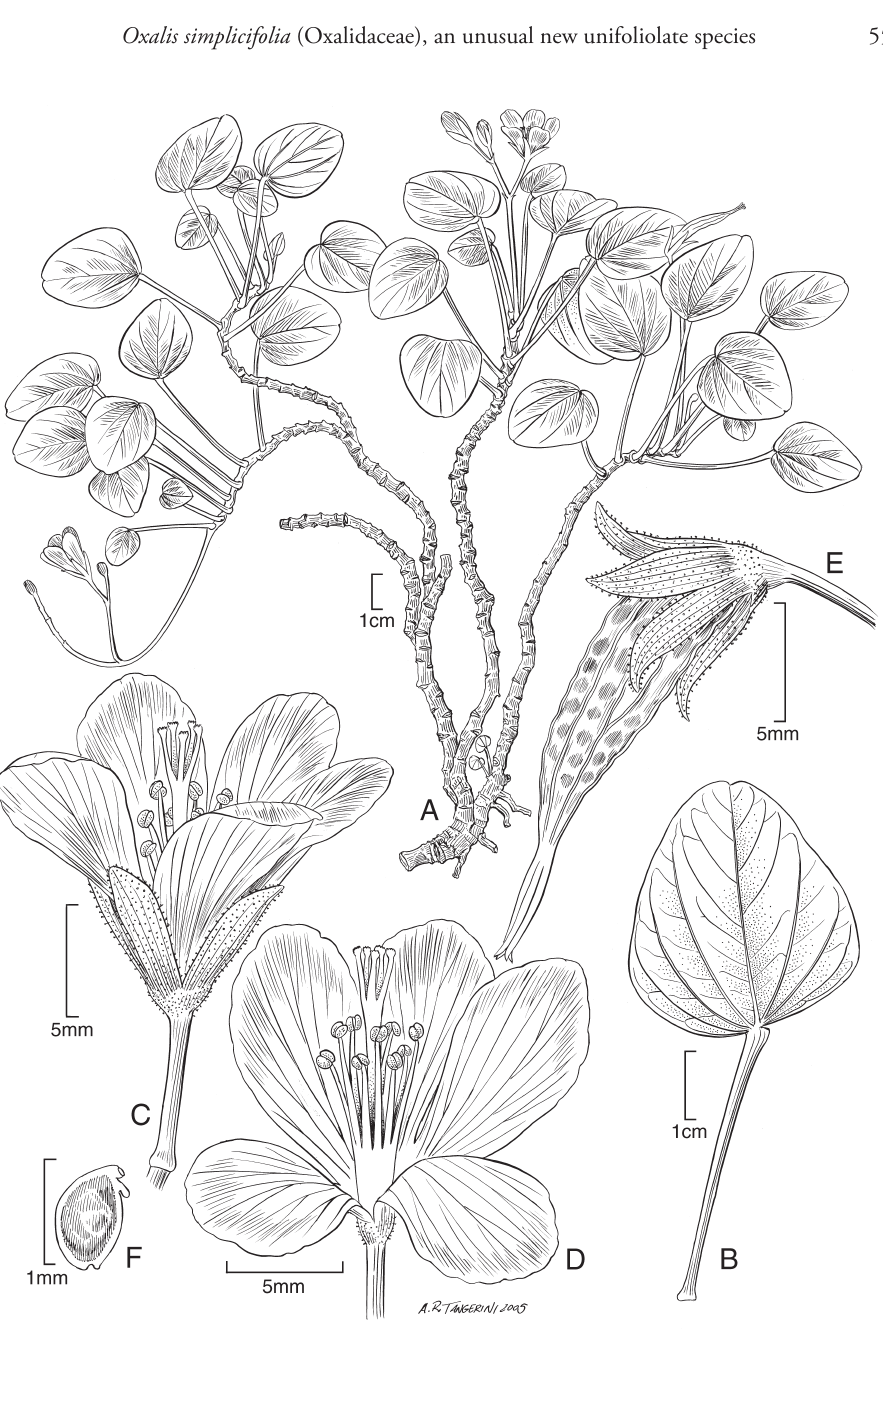
Figure 1. Oxalis simplicifolia Lorence & WL Wagner A habit B leaf C, D flowers e fruit F seed. Drawn from the type collection (Perlman & Wood 10972) and field